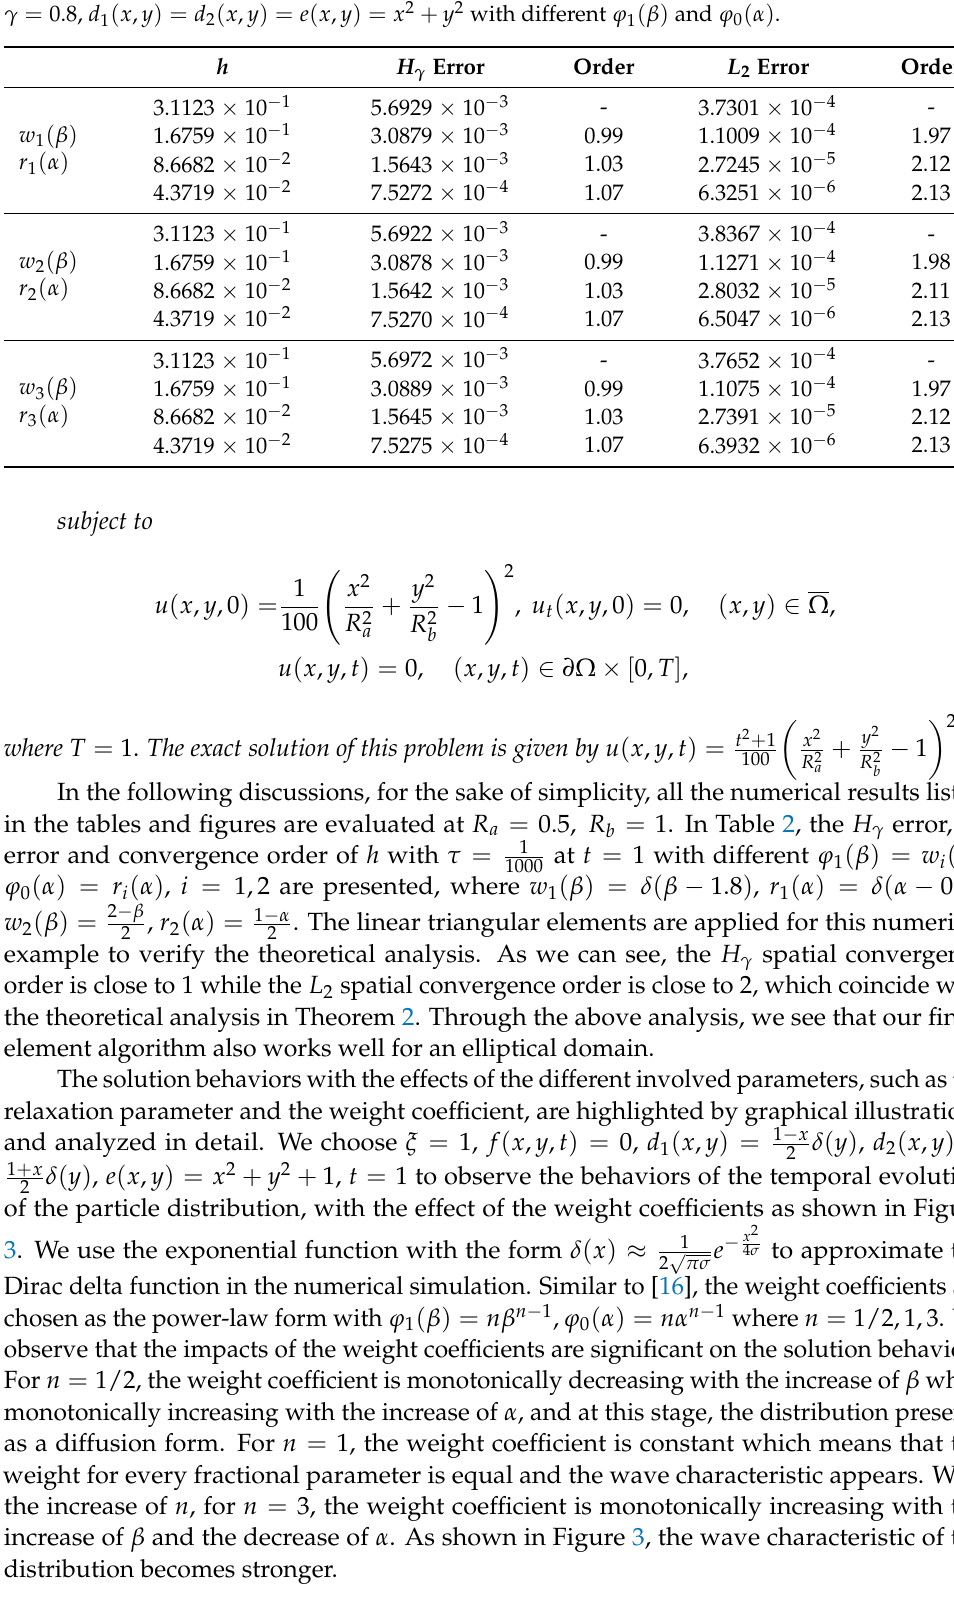
Table 1. The H γ error, L 2 error and convergence order of h with τ = 1